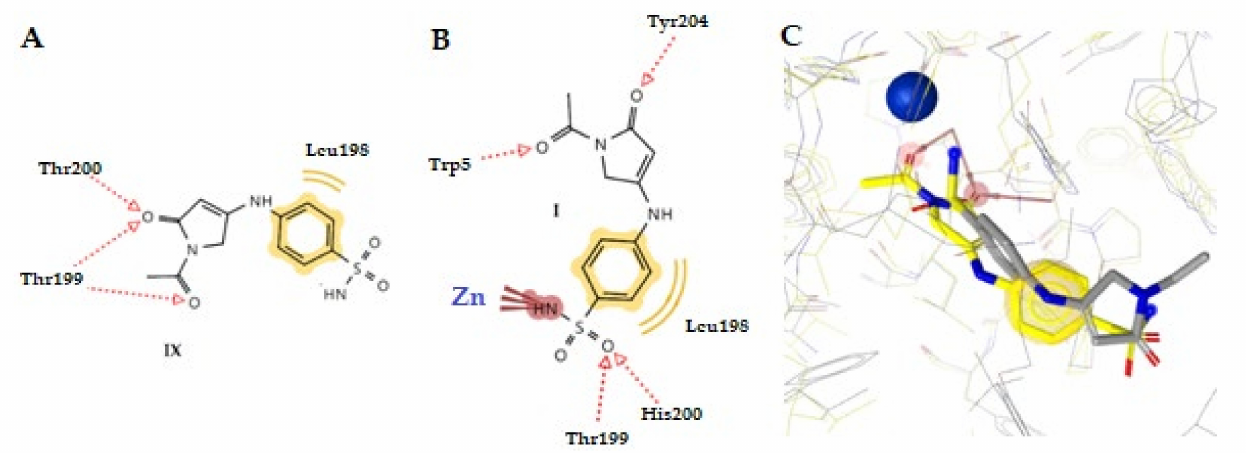
Figure 7. 2D interaction diagram of compound 1g docking pose interactions with the key amino acids in ( A ) hCA IX and ( B ) hCA I. ( C ) Superposition of compound 1g bound to hCA I (yellow) in comparison to hCA IX (grey). Active-site zinc shown as blue sphere, red dotted arrows indicate H-bonds, and yellow spheres are hydrophobic